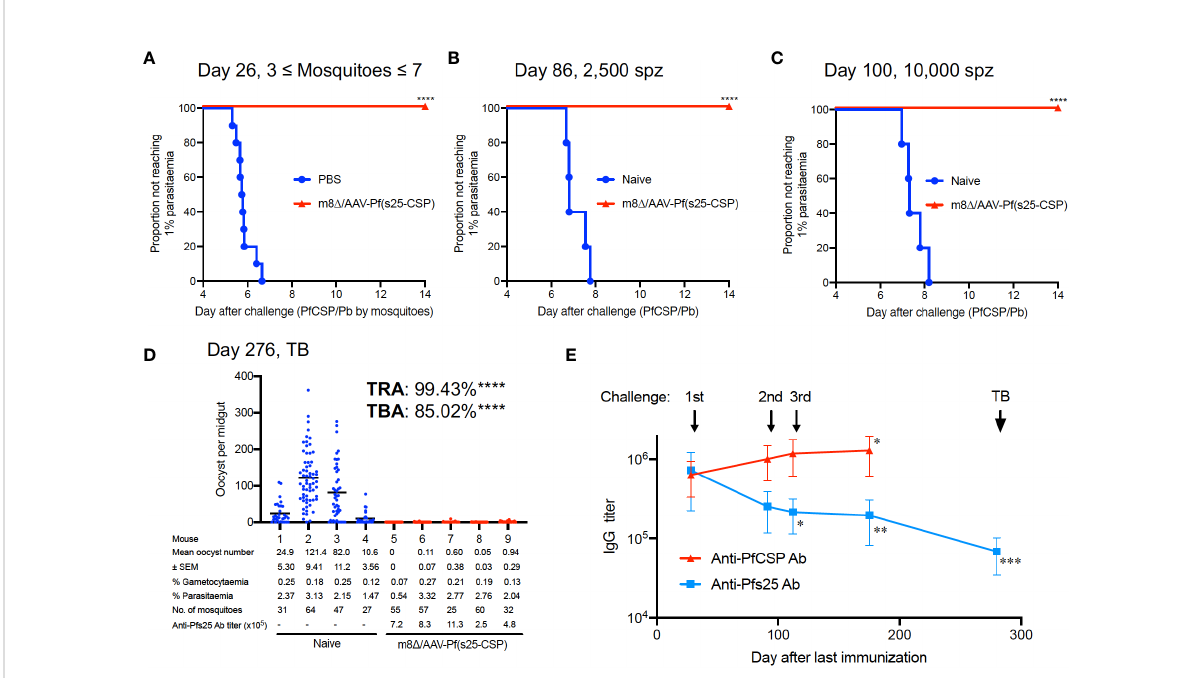
FIGURE 4 Multiple parasite exposure. (A) Protective ef fi cacy in mice immunized with m8 D /AAV-Pf(s25-CSP) (n = 10) after challenge by the bites of PfCSP/ Pb sporozoite-infected mosquitoes at day 26 after the last immunization. (B, C) Protective ef fi cacy in the protected mice in (A) against 2,500 (B) , day 86) and 10,000 PfCSP/Pb sporozoites (C) , day 100). (D) TB ef fi cacy in the protected mice at day 276 (n = 5) versus naïve mice (n = 4). (E) IgG antibodies against PfCSP and Pfs25 at the indicated time points before each challenge and TB studies. P values (day 25 versus others) were calculated using ANOVA followed by Dunnett ’ s multiple comparisons test. *p < 0.05; **p < 0.01; ***p < 0.0001; ****p <